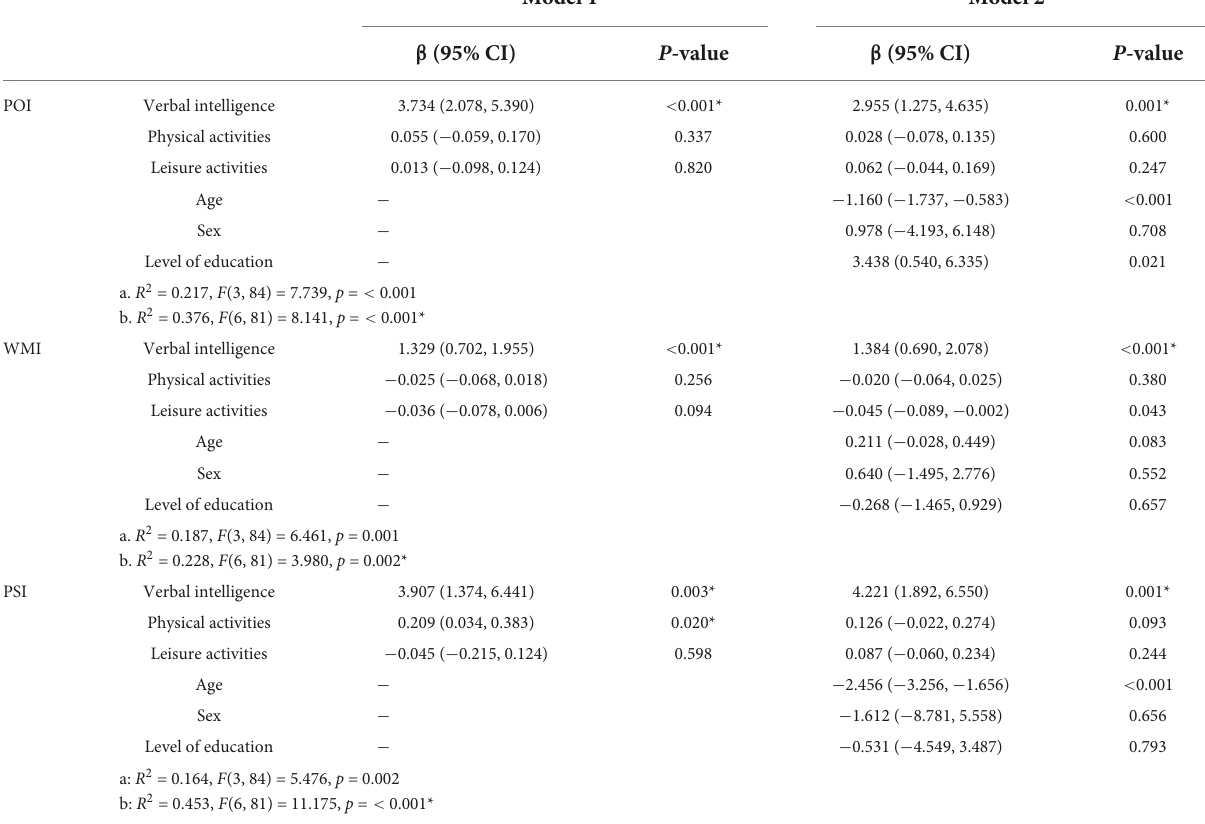
TABLE 2 Multiple linear regression analysis with WAIS-III-R indices as